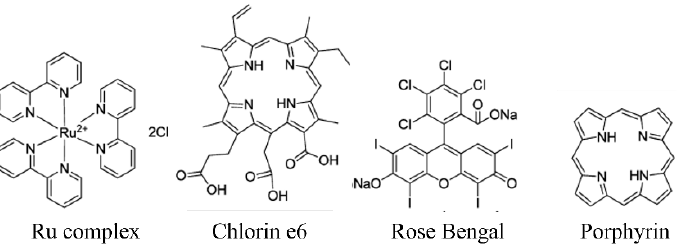
Figure 5. Chemical structures of photosensitizers for photodynamic therapy (PDT) (add MB and ZnPc).